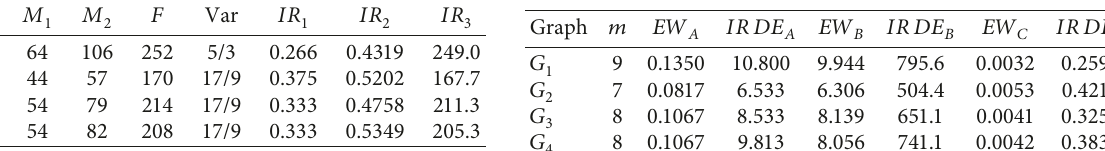
Table 3: Computed topological indices of the four graphs shown in Figure 1.